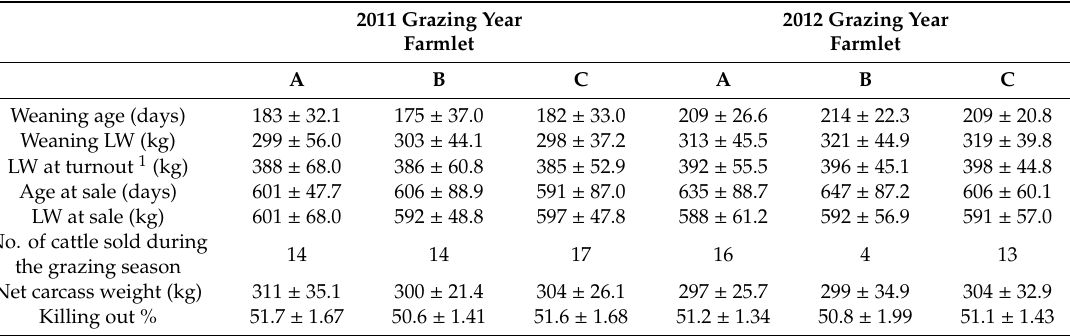
Table 5. Live weights (LW) and sales data for cattle born in spring 2010 (25 heads per farmlet) and spring 2011 (27 heads per farmlet) (average ± SD).